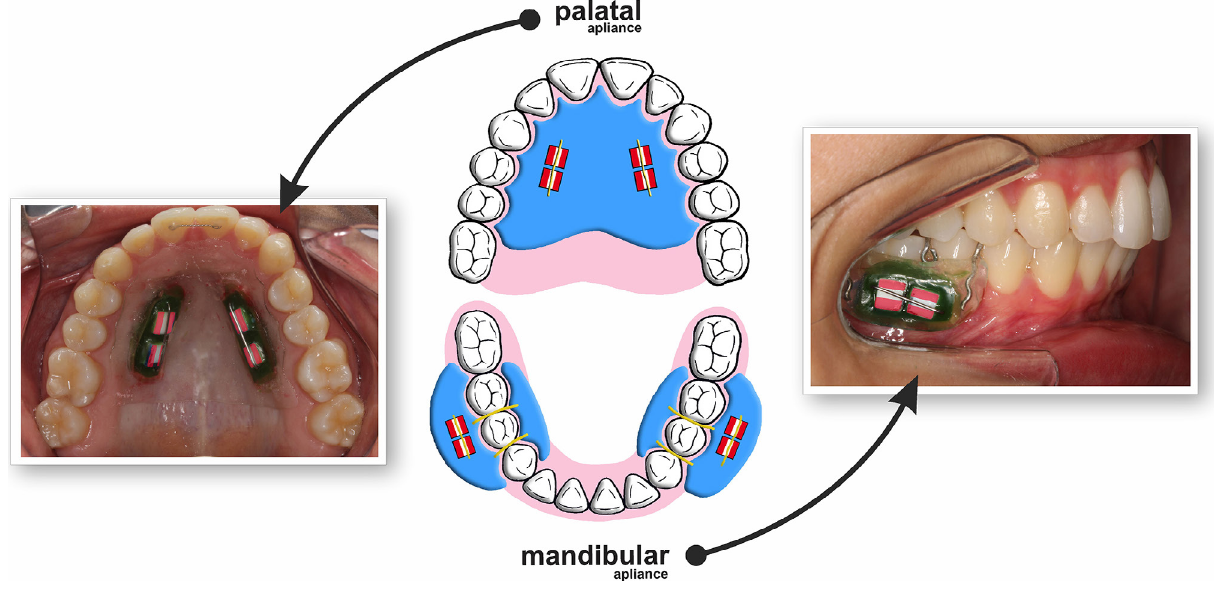
Figure 1- Characteristics of the palatal and mandibular